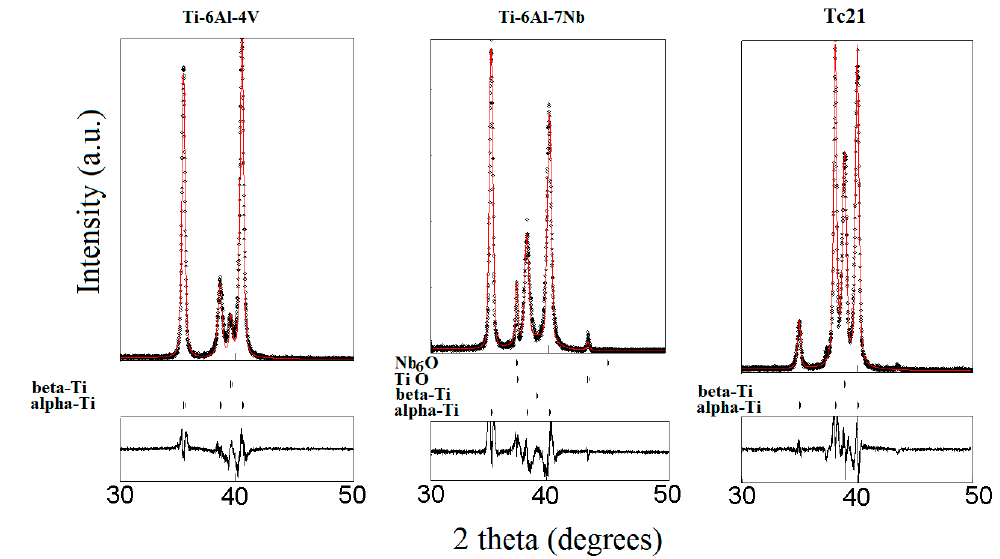
Figure 4. The calculated (red line) and recorded (black dots) diffraction patterns for the three alloys as obtained from the Rietveld adjustments using the MAUD program; the positions of the Bragg reflections of each phase and the difference between the calculated and observed patterns are also presented at the bottom.